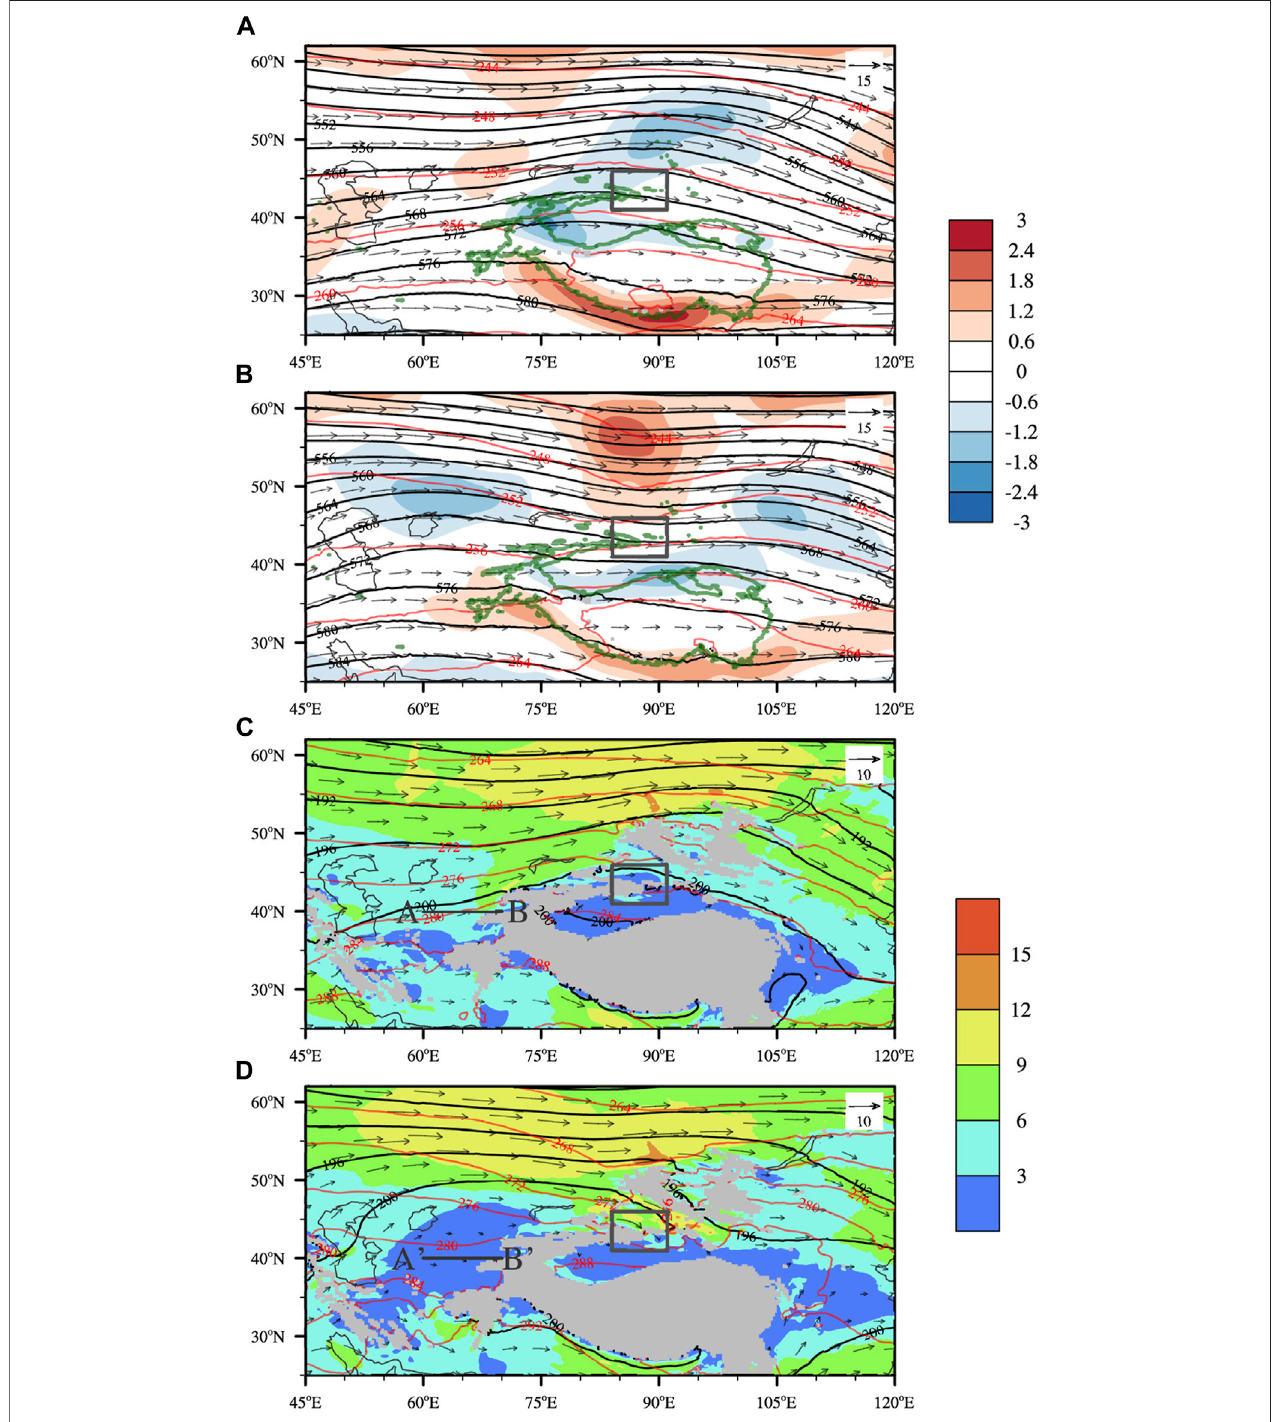
FIGURE 9 | Composite geopotential height (black contours, unit:10 gpm), temperature (red contours, unit: K), horizontal wind fi elds (vectors) and relative vertical vorticity(shading,unit:10 − 4 s − 1 )at500 hPainthecasesof (A) Low_Windand (B) High_Wind. (C) and (D) arethesameas (A) and (B) butat800 hPawiththeshadingfor horizontal wind speed (unit: ms − 1 ). The green isolines in (A) and (B) denote the elevation of 3,000 m, while the black boxes indicate the location of the Tianshan Grand Canyon (TGC). Line AB and Line A ’ B ’ indicate the vertical planes on which Froude Numbers are calculated.